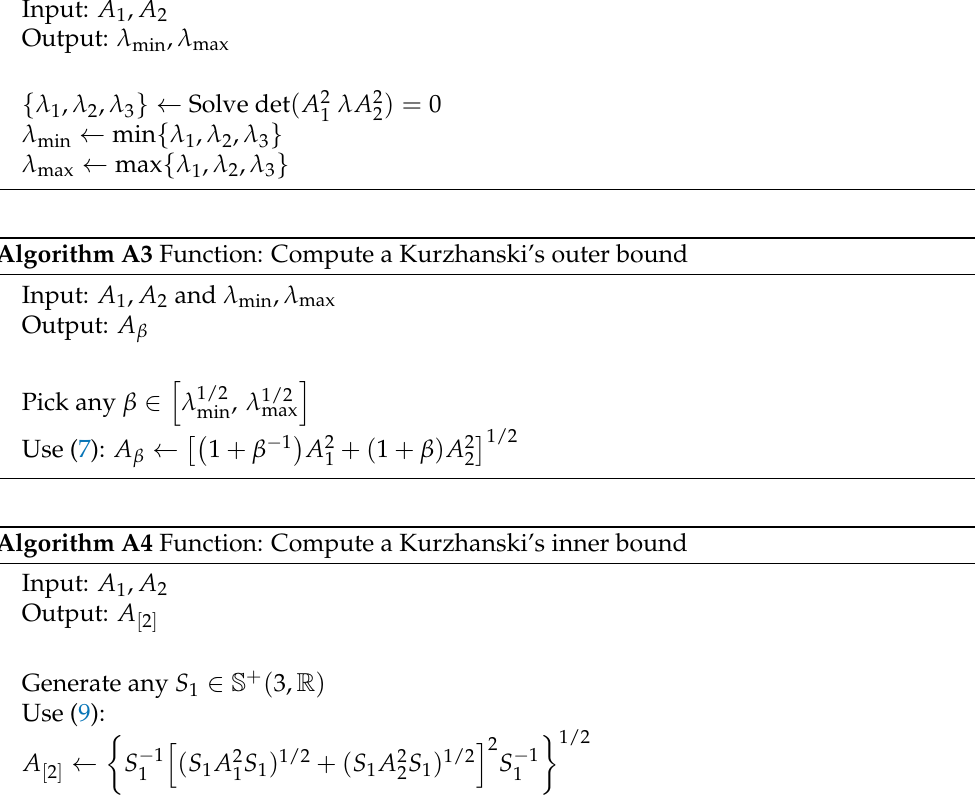
Algorithm A5 Function: Compute MVOE